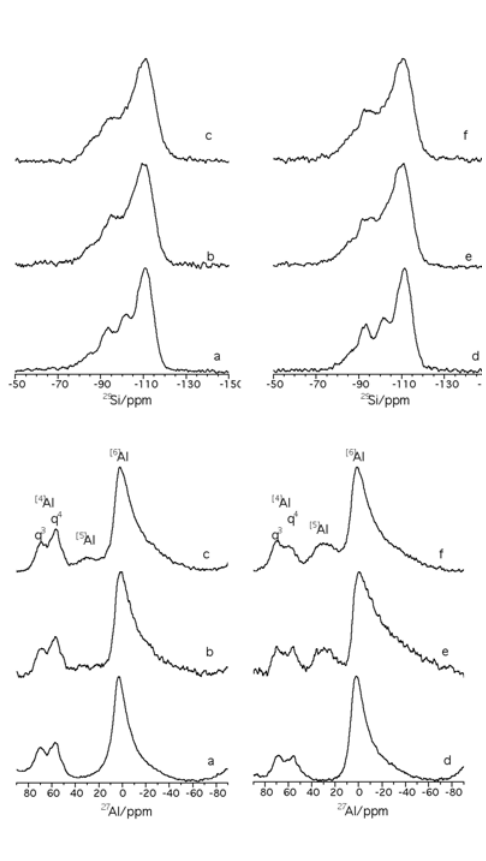
5. 29 Si- (top) and 27 Al- (bottom) MAS-NMR spectra of acid treated montmorillonites (a) K10; (b) K10/TMA; (c) K10/TEA; (d) K30; (e) K30/ TMA; (f) K30/TEA.